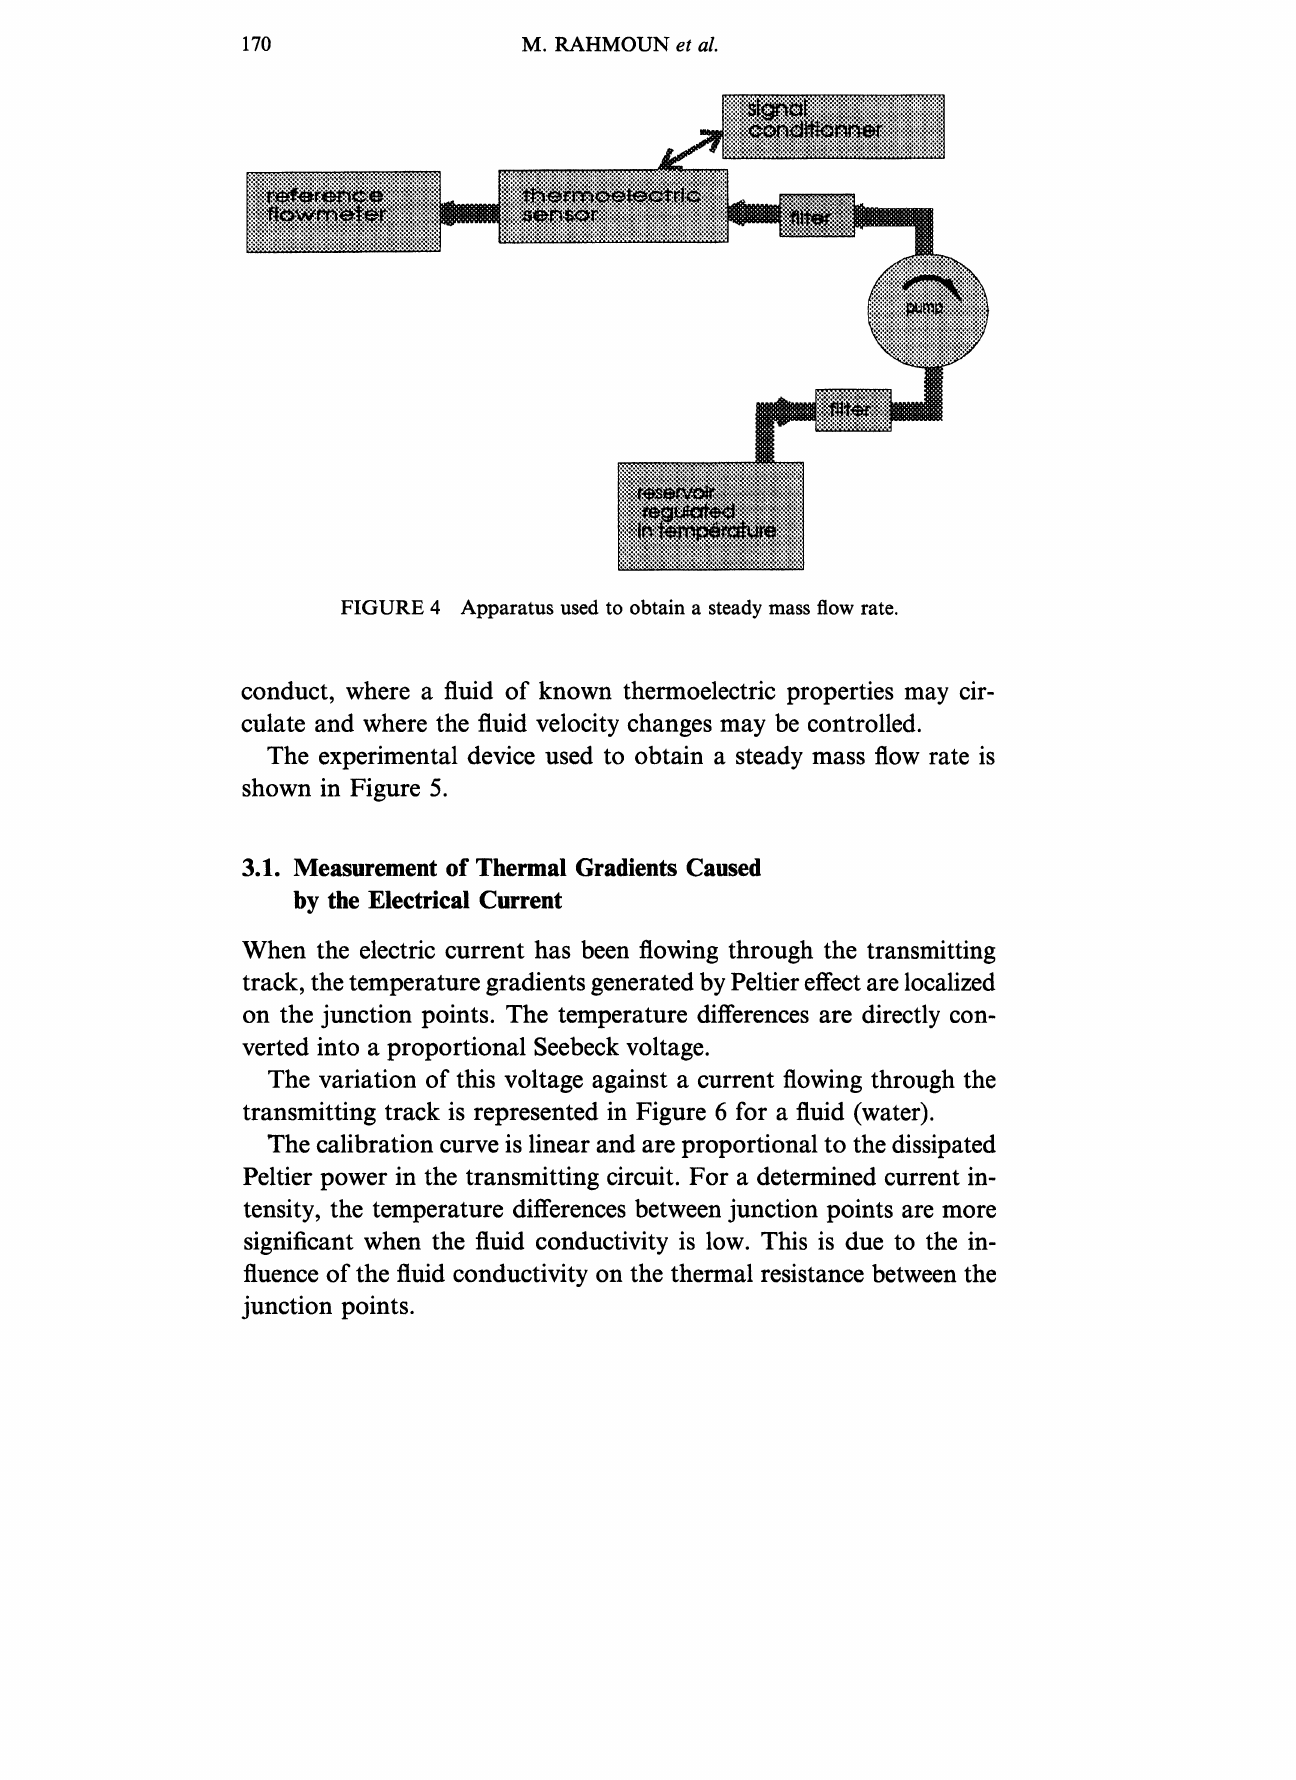
FIGURE 4 Apparatus used to obtain a steady mass flow